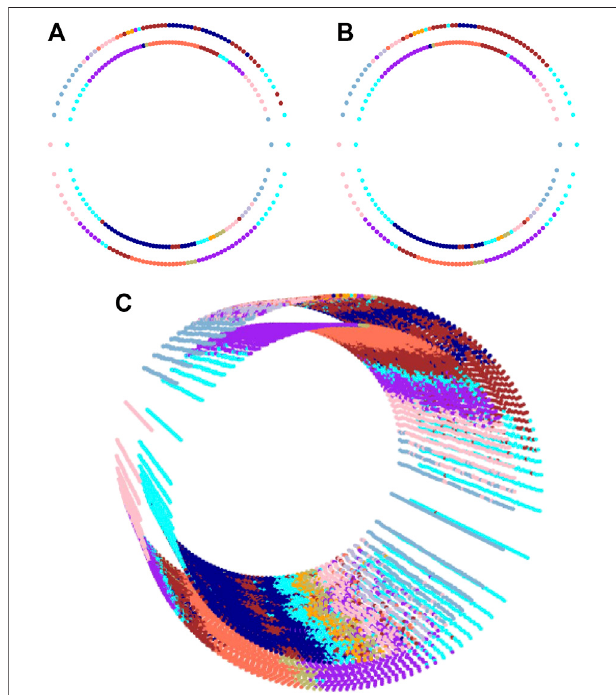
FIGURE 6 | 3D cylinder representation of evolution of rhythmical cycles inL+Rsystemofsubject#5. (A) Concentric-ringforarhythmiccyclefromthe middle of [ 1 , 10 , 000 ] . (B) Concentric-ring for a rhythmic cycle from the fi nal part of [ 1 , 10 , 000 ] . (C) 3D cylinder representation of evolution of rhythmic cycles from the third to the 70th.